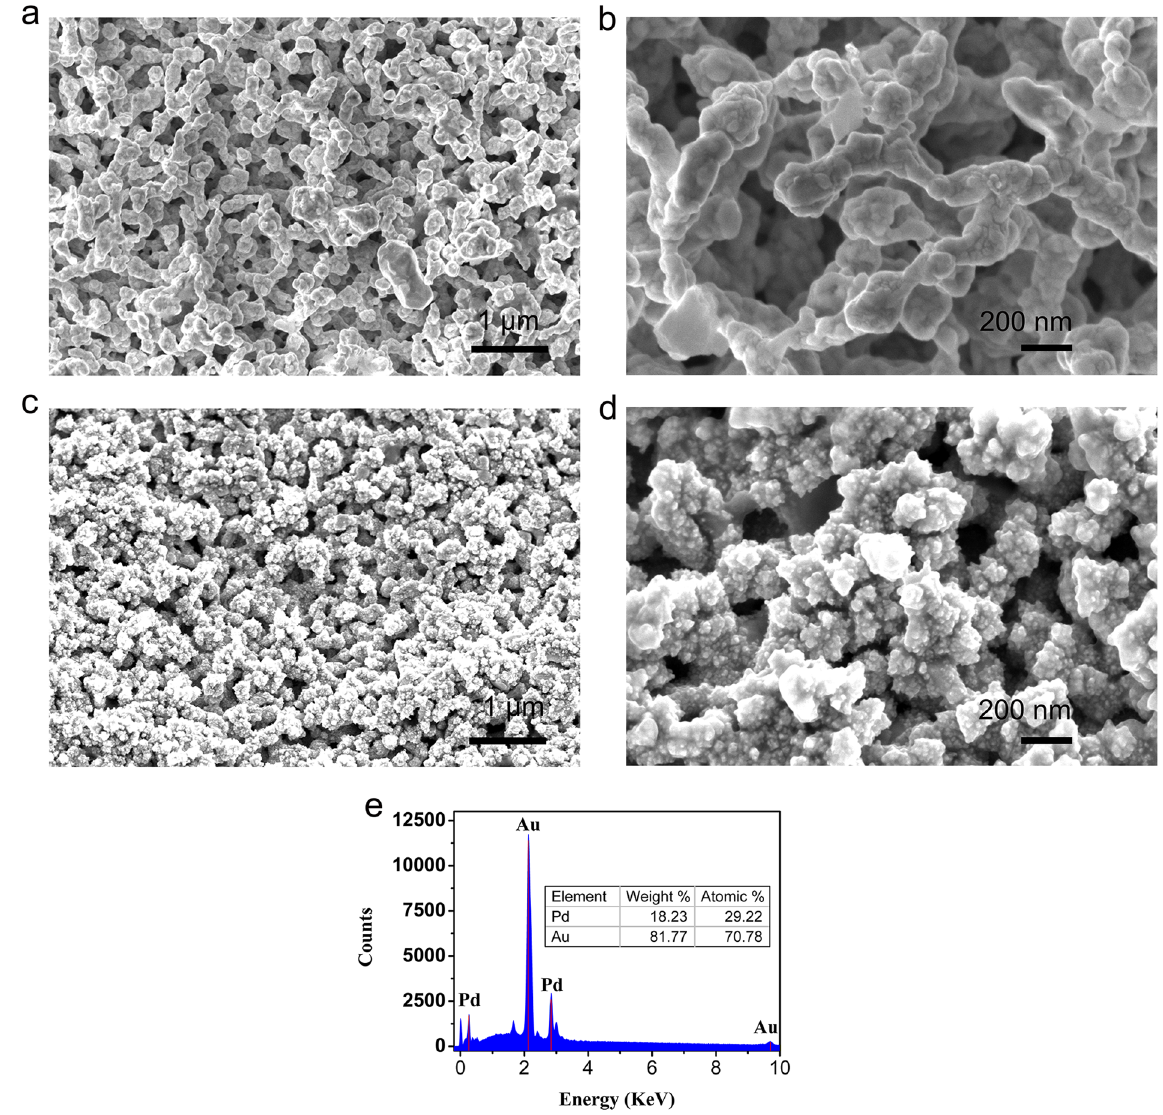
nanoporous structure. ( c ) Low-magnification and ( d ) high-magnification SEM images of Pd/NPG wire prepared by Pd electrodepositing on NPG wire, indicating the Pd distributing along the ligament of NPG wire uniformly. ( e ) Energy dispersive spectrum of Pd/NPG